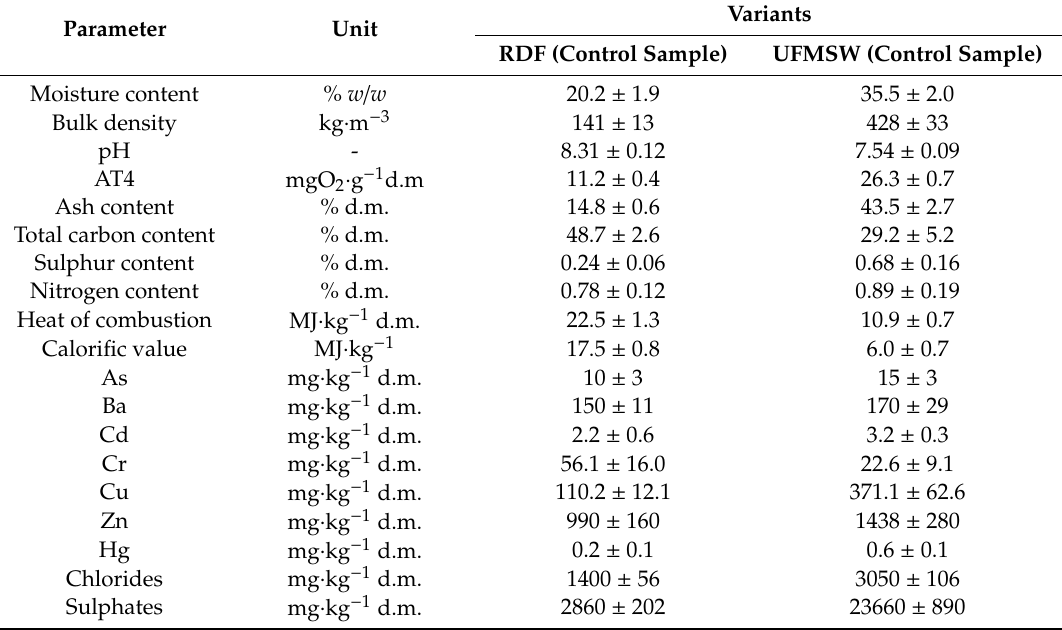
Table 2. List of basic physicochemical characteristics of refuse-derived fuel (RDF) and undersized fraction of municipal solid waste (UFMSW) (control samples, own research).